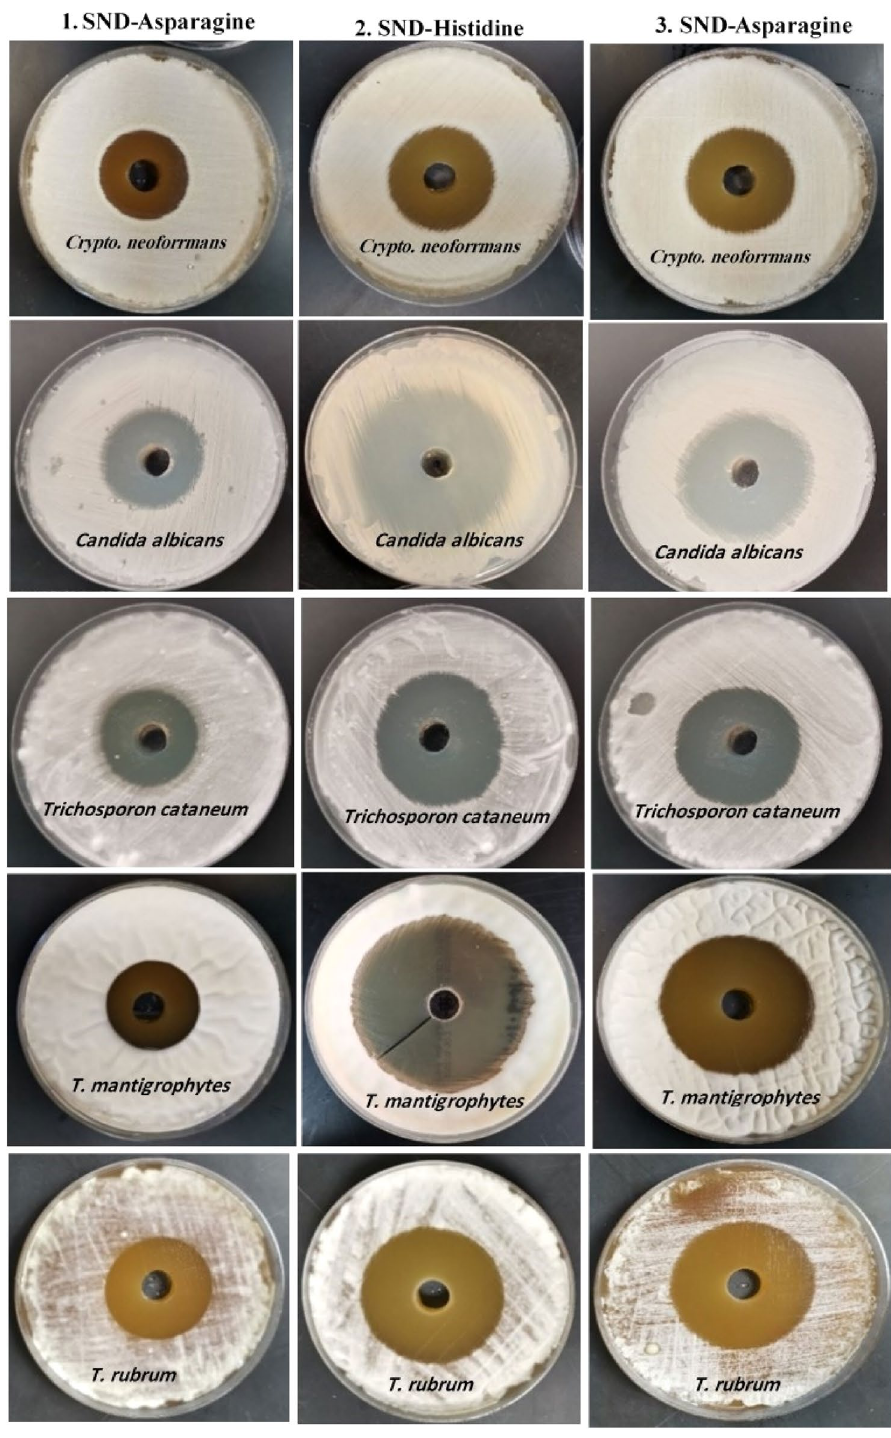
Figure 12. Antimicrobial activity of the surfactants in comparison to traditional antifungals against dermatophyte yeasts and fungi indicated by clear zone diameter